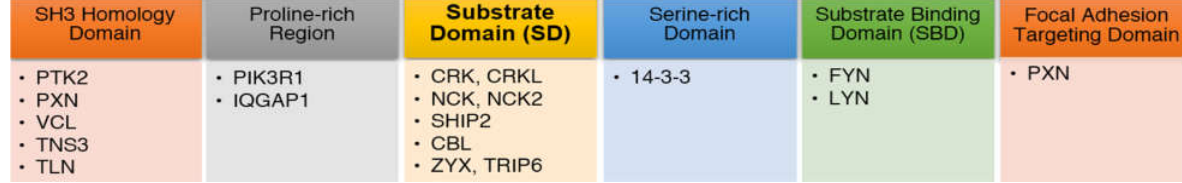
Figure 3. Proteins are indicated, which have been detected in our proteome analyses described in refs. [35,36]. They are assigned to BCAR1 domains and region described in the literature [see introduction, third section], with which they interact.